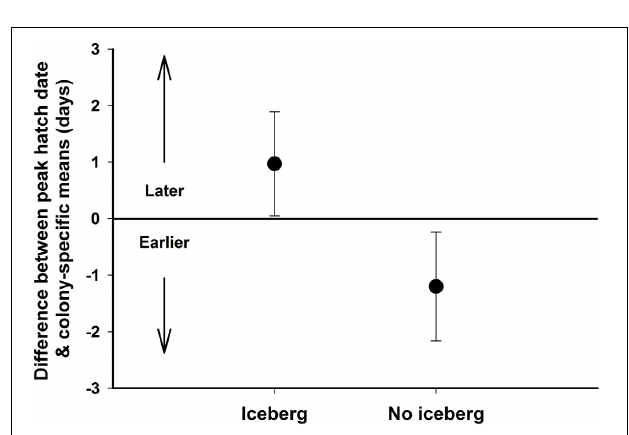
Crozier on Ross Island, Antarctica when icebergs were present (2001–2005) and when icebergs were not present (1997–2000, 2006–2008).